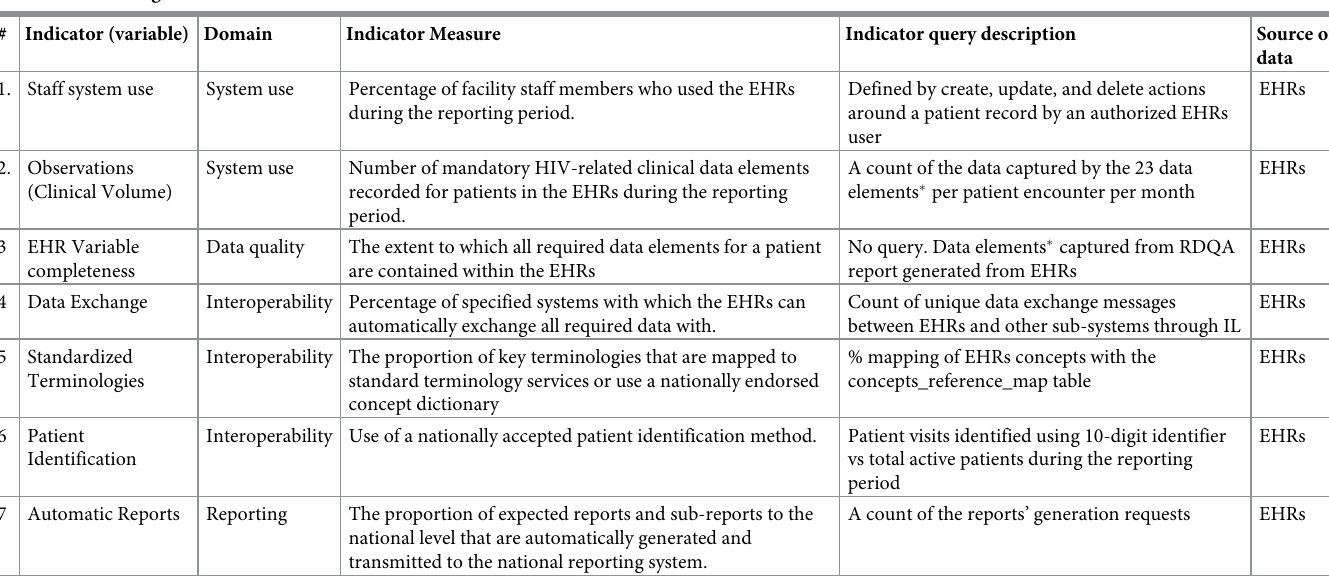
Table 1. EHRs usage indicators